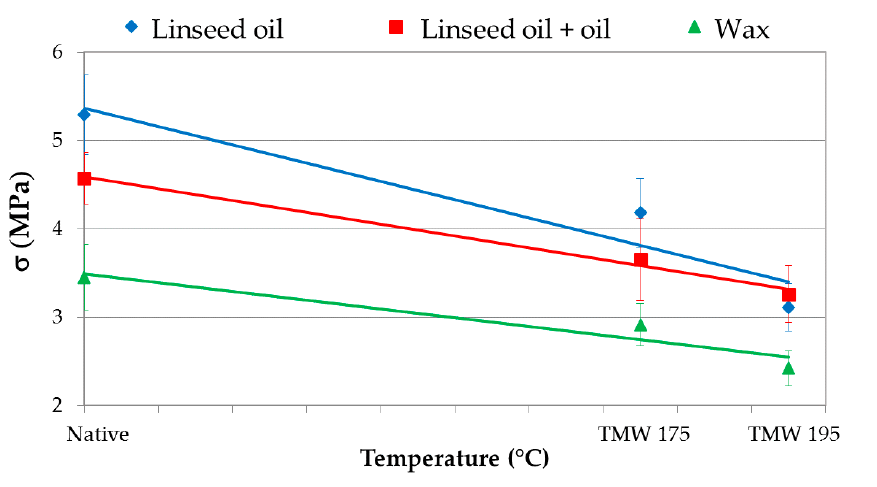
Figure 2. Linear correlation between the adhesion ( σ ) of surface finishes and the temperature used for thermal modification of Turkey oak wood.